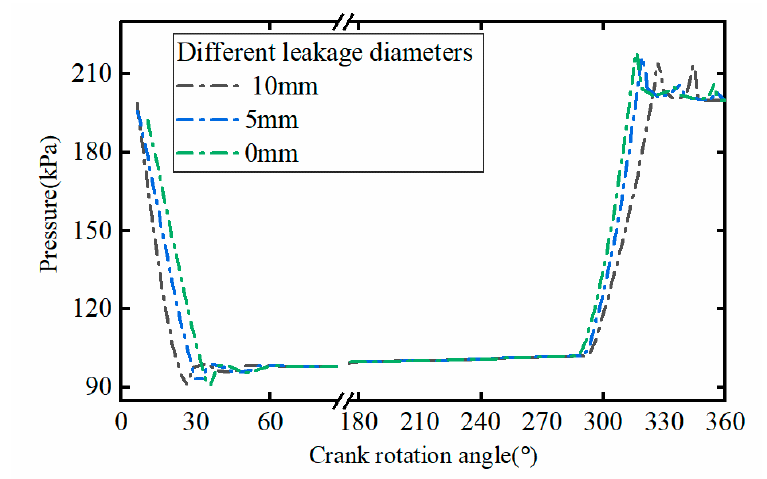
Figure 14. The cylinder pressure with different leakage diameter holes under the regulating condition.